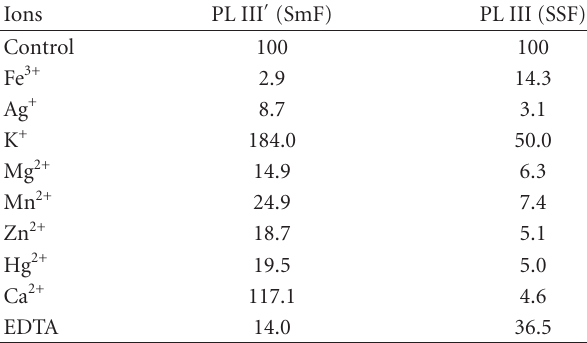
Table 1: Influence of ions on the activity of fraction III obtained by Sephadex-G75 chromatography of PLs produced by SSF and